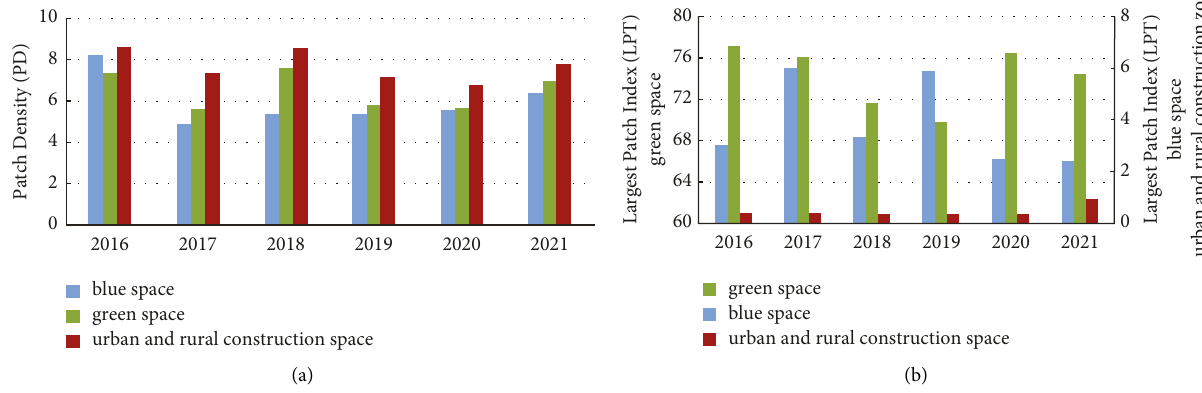
Figure 7: Patch properties of BGS and construction space in urban and rural areas of Baiyangdian Wetland from 2016 to